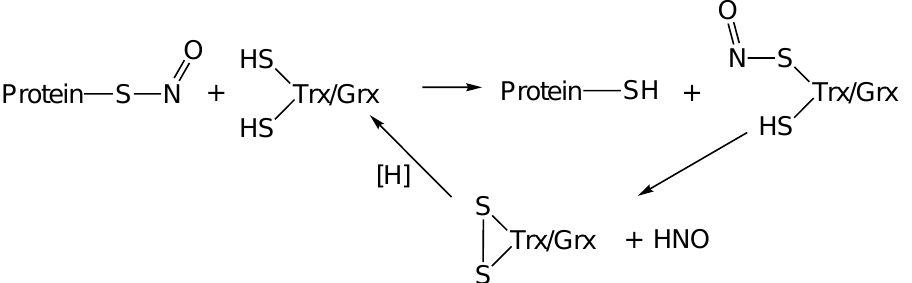
Figure 2. Possible mechanism for the Trx/Grx-mediated denitrozation of a protein RS-NO. [H] represents known biological pathways for RSSR reduction to the corresponding RSH.